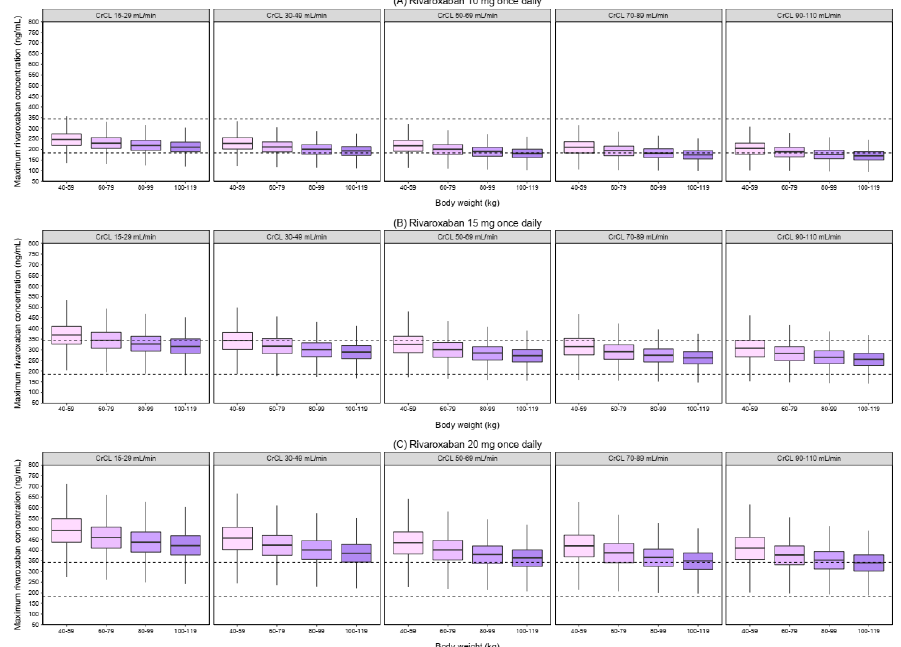
Figure 3. Simulated maximum concentration (C MAX ) of rivaroxaban with different dosing regimens. The boxplots represent the predicted C MAX stratified by creatinine clearance and body weight. ( A ) rivaroxaban 10 mg once daily. ( B ) rivaroxaban 15 mg once daily. ( C ) rivaroxaban 20 mg once daily. The dashed lines represent the 5th and 95th percentile ranges of the typical C MAX (184–343 ng/mL) reported in patients with non-valvular atrial fibrillation receiving 20 mg of rivaroxaban [19].